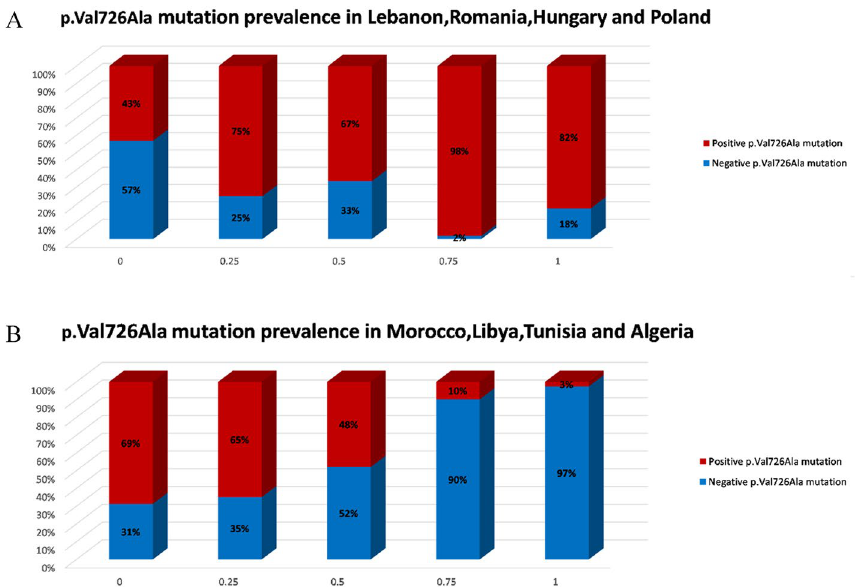
Figure 3. Prevalence of the countries of origin most indicative for the p.Val726Ala variant: ( A ) Lebanon, Romania, Hungary, and Poland are the countries of origin most positively associated with the p.Val726Ala variant. ( B ) Morocco, Libya, Tunisia, and Algeria are the countries of origin most negatively associated with the p.Val726Ala variant. Red and blue bars indicate patients who carry and do not carry the p.Val726Ala variant, respectively. The x-axis indicates the amount of grandparents from the four countries (0 being none, 1 being all four).